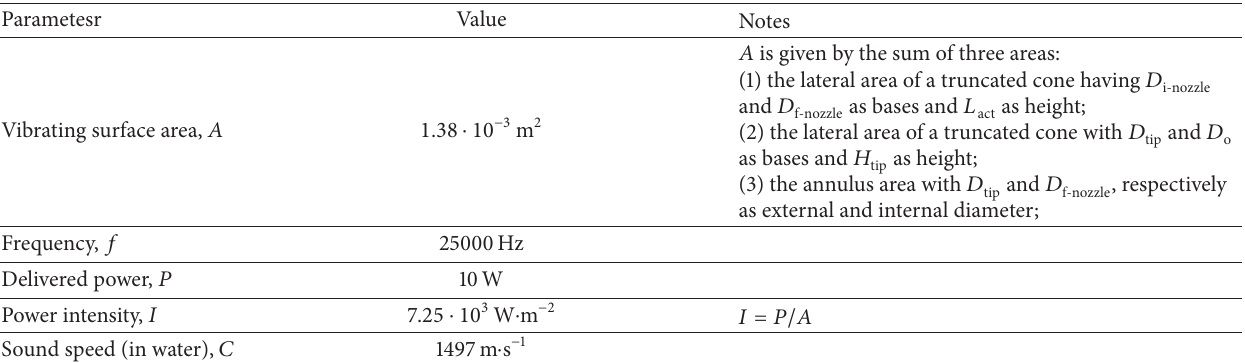
Table 4: Values used in correlations for droplet size prediction in ultrasonic atomization.